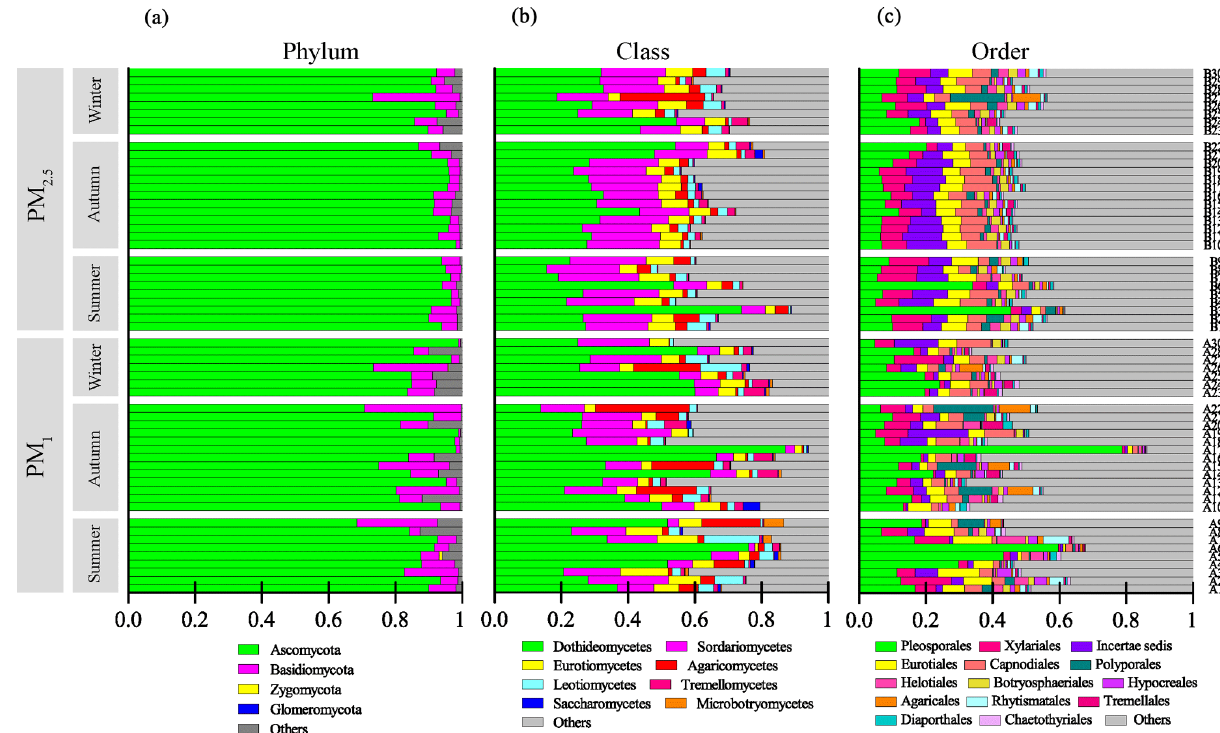
Figure 3. Relative abundances of fungal communities of PM 2 . 5 and PM 1 at phylum (a) , class (b) , and order level (c)